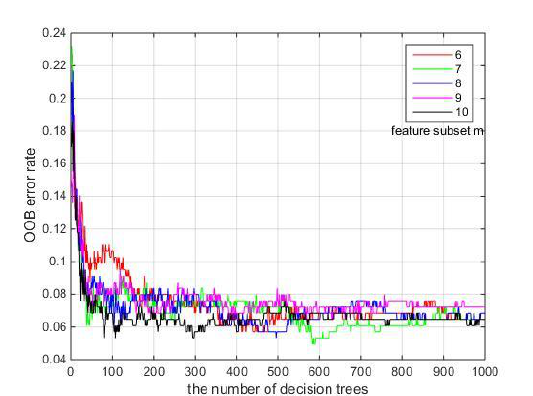
Figure 6. The relationship between OOB and parameters